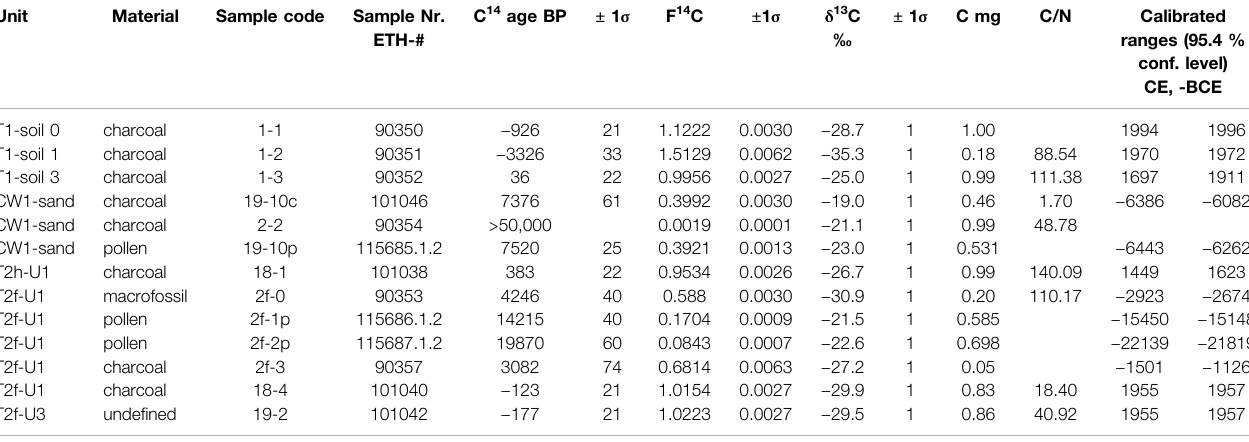
TABLE 1 | Results of AMS analysis on samples selected from organic-rich layers and the total organic carbon (TOC) content of various fractions of sediments. BP (cid:1) before present (before 1950 AD). F14C is the concentration measured in the sample, corrected for fractionation, and normalized to the 1950 value and the corresponding 14C age. δ C13 is a value measured on graphite and can include additional fractionation. C/N ratio isan atomic ratio (C/N) × (14/12). The mass C is the fi nal carbon content ofthe sample. Calibration was performed using the OxCal calibration with the INTCAL20 calibration curve (Reimer et al., 2020). The samples with F 14 C > 1 indicate the post-1950 source of carbon (modern). The corresponding calendar ages were obtained using Bomb Peak 14 C data (Hua et al., 2013; Levin et al., 2013) and the online calibration software http://calib.org/CALIBomb/.